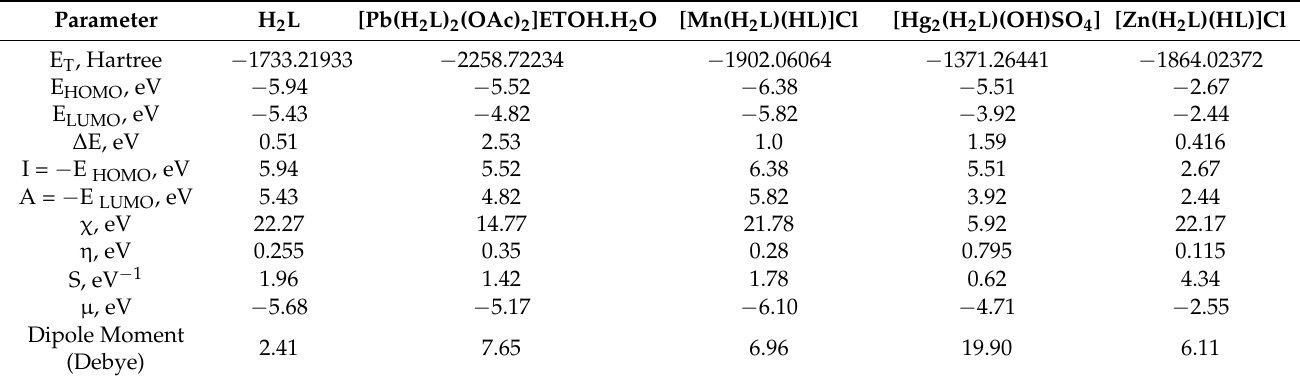
Table 8. Ground state properties of the H 2 L ligand using B3LYP/6-31G and its metal complexes using B3LYP/LANL2DZ.